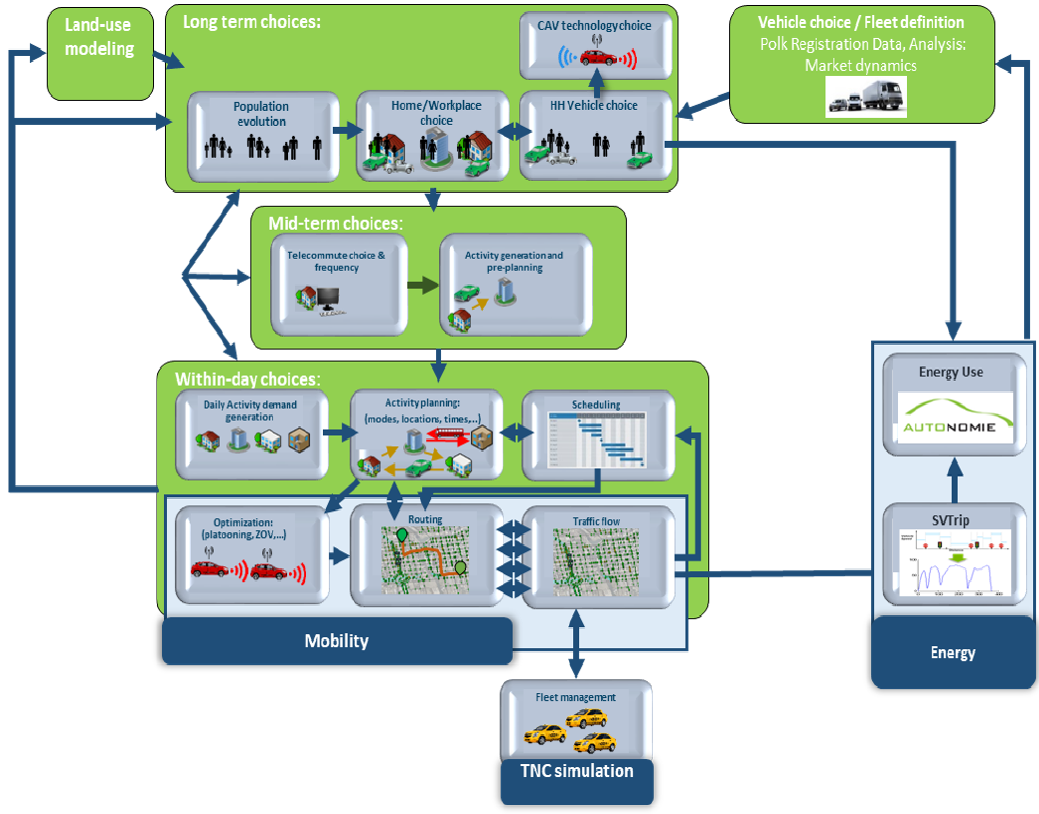
Figure 1. CAVs modeling using POLARIS &